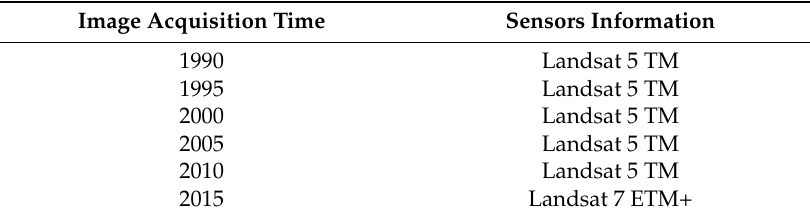
Table 1. Sensors of the remote sensing